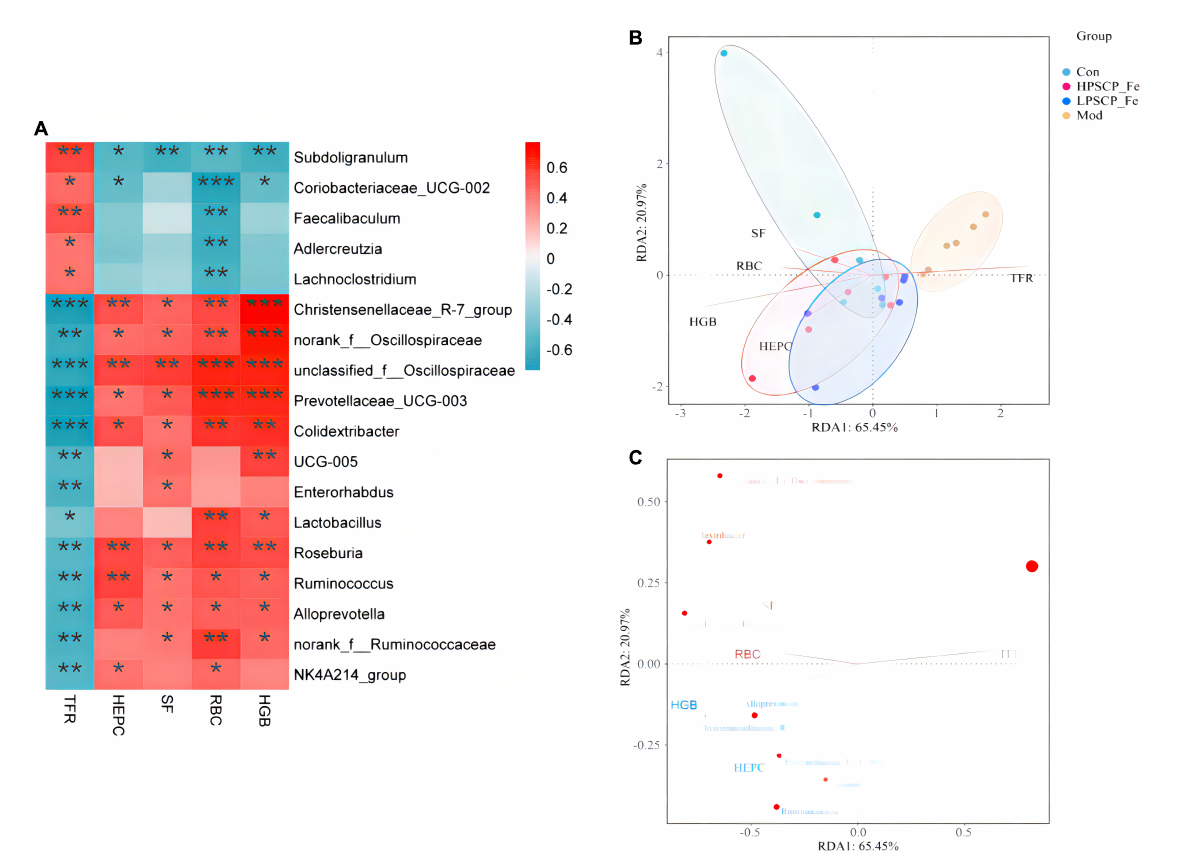
FIGURE5 Correlation analysis between related factors and microbiota at the genus level (A) . Spearman’s correlation analyses were used to analyze the relative abundance (%) between the specific genus in each treatment group. 0.01 < * p ≤ 0.05, 0.001 < ** p ≤ 0.01, *** p ≤ 0.001. (B) The db-RDA analysis result in different groups. (C) The db-RDA analysis result of gut flora and the related